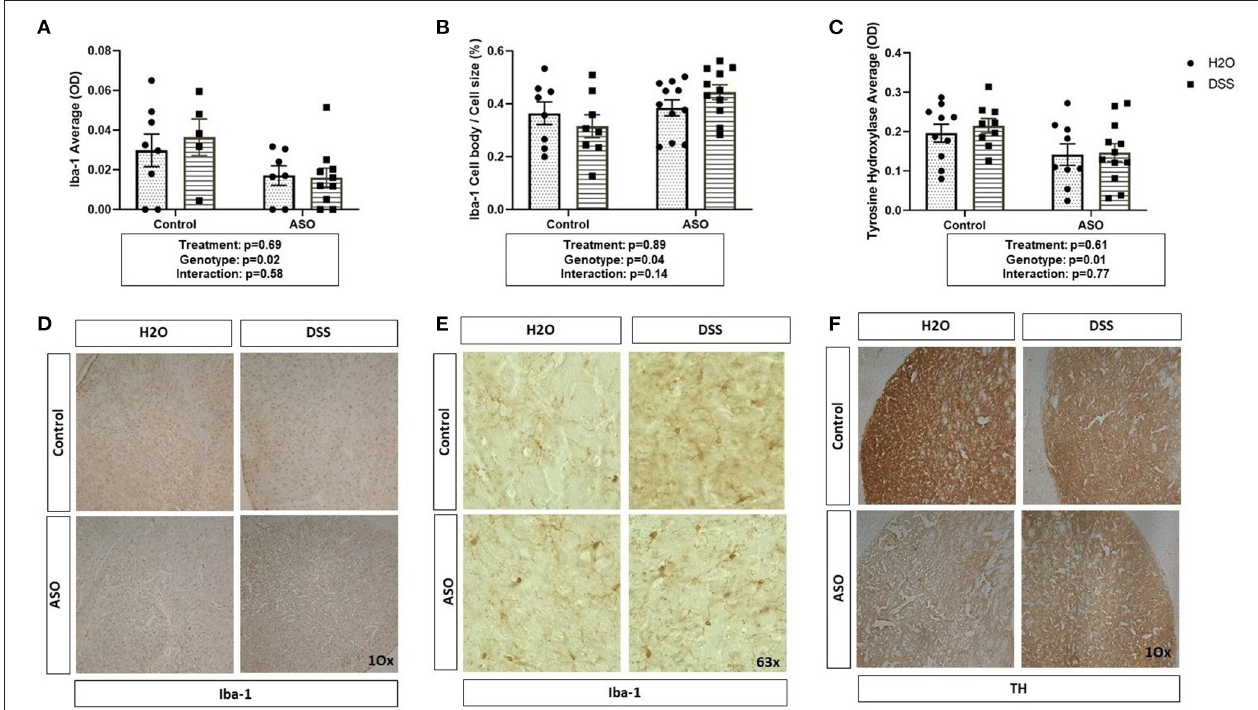
FIGURE 6 | Brain related PD outcome measures exhibit genotypic ASO but not DSS treatment effects. Mice were evaluated for brain pathology. (A) ASO mice had a significantly lower amount of microglia than controls. (B) ASO mice had significantly more activated microglia than WT. (C) ASO mice had a significantly less TH than control. (D) Representative images of Iba-1 positive microglia at 10x magnification. (E) Representative images of Iba-1 positive microglia at 63x magnification. (F) Representative images of TH positive dopaminergic terminals at 10x magnification Outliers were omitted prior to analysis ( > 2 standard deviations from the mean). (A–C) Two-way ANOVA was conducted and values for different factors are indicated in the graphs followed by post-hoc Tukey (no post hoc significance was identified). ASO, α -synuclein overexpressing; H 2 O, water; DSS, dextran sodium sulfate; TH, Tyrosine hydrolase; Iba-1, Ionized calcium binding adaptor molecule